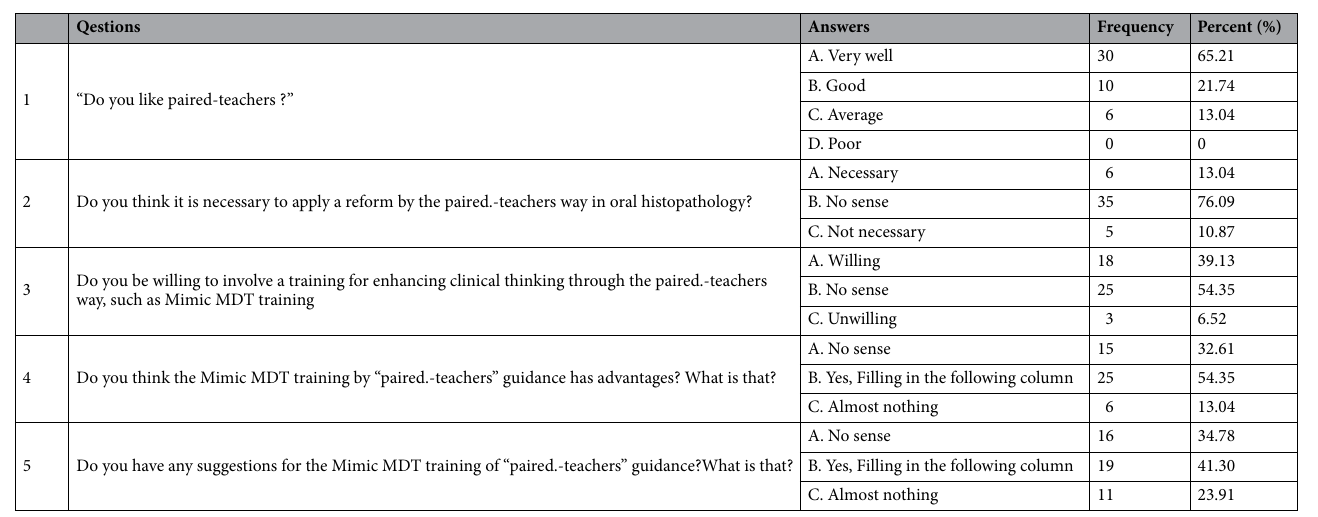
Table 2. Survey on the recognition of Mimic MDT training based on